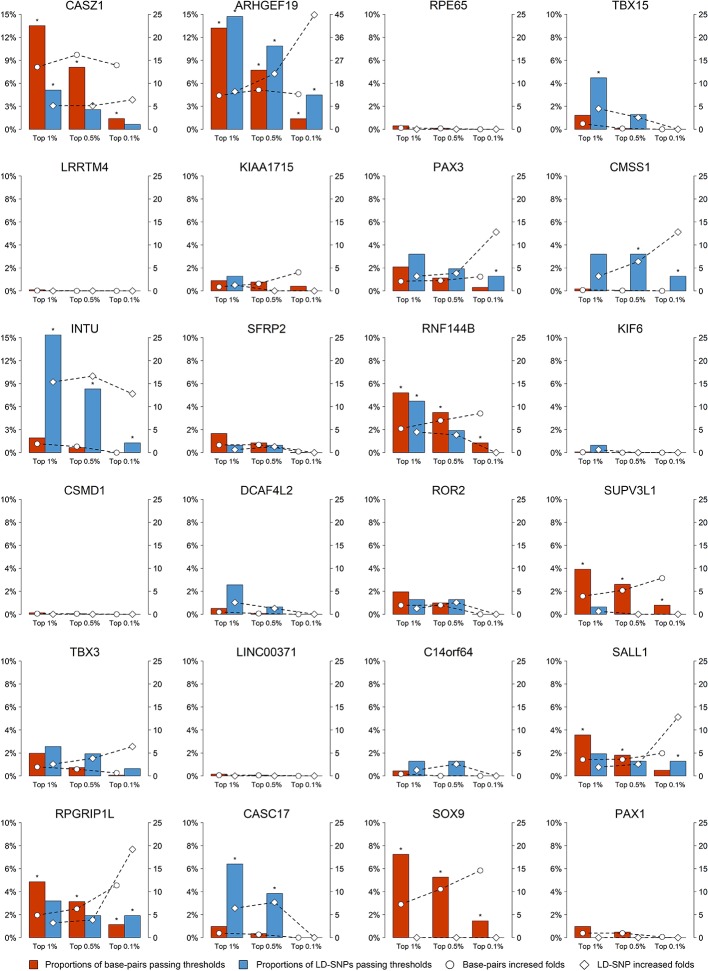
Overview of regulation activity of 24 face-associated loci in CNCCs.For the top-associated SNPs at the 24 face associated loci, their base-pairs in vicinity within 20 kb (red bar) and LD (r2 > 0.25) SNPs (blue bar) were examined for cis-regulatory entries in six epigenomic tracks in CNCCs at three thresholds (top 1%, top 0.5%, top 0.1% of the genome). The proportions of the base-pairs or LD SNPs at each locus passing the set thresholds were displayed using bars (left y-axis), and the folds of the increase over the set thresholds were displayed using dashed lines (right y-axis). Statistical significance was derived using the Fisher’s exact test (*adjust.p<0.05).